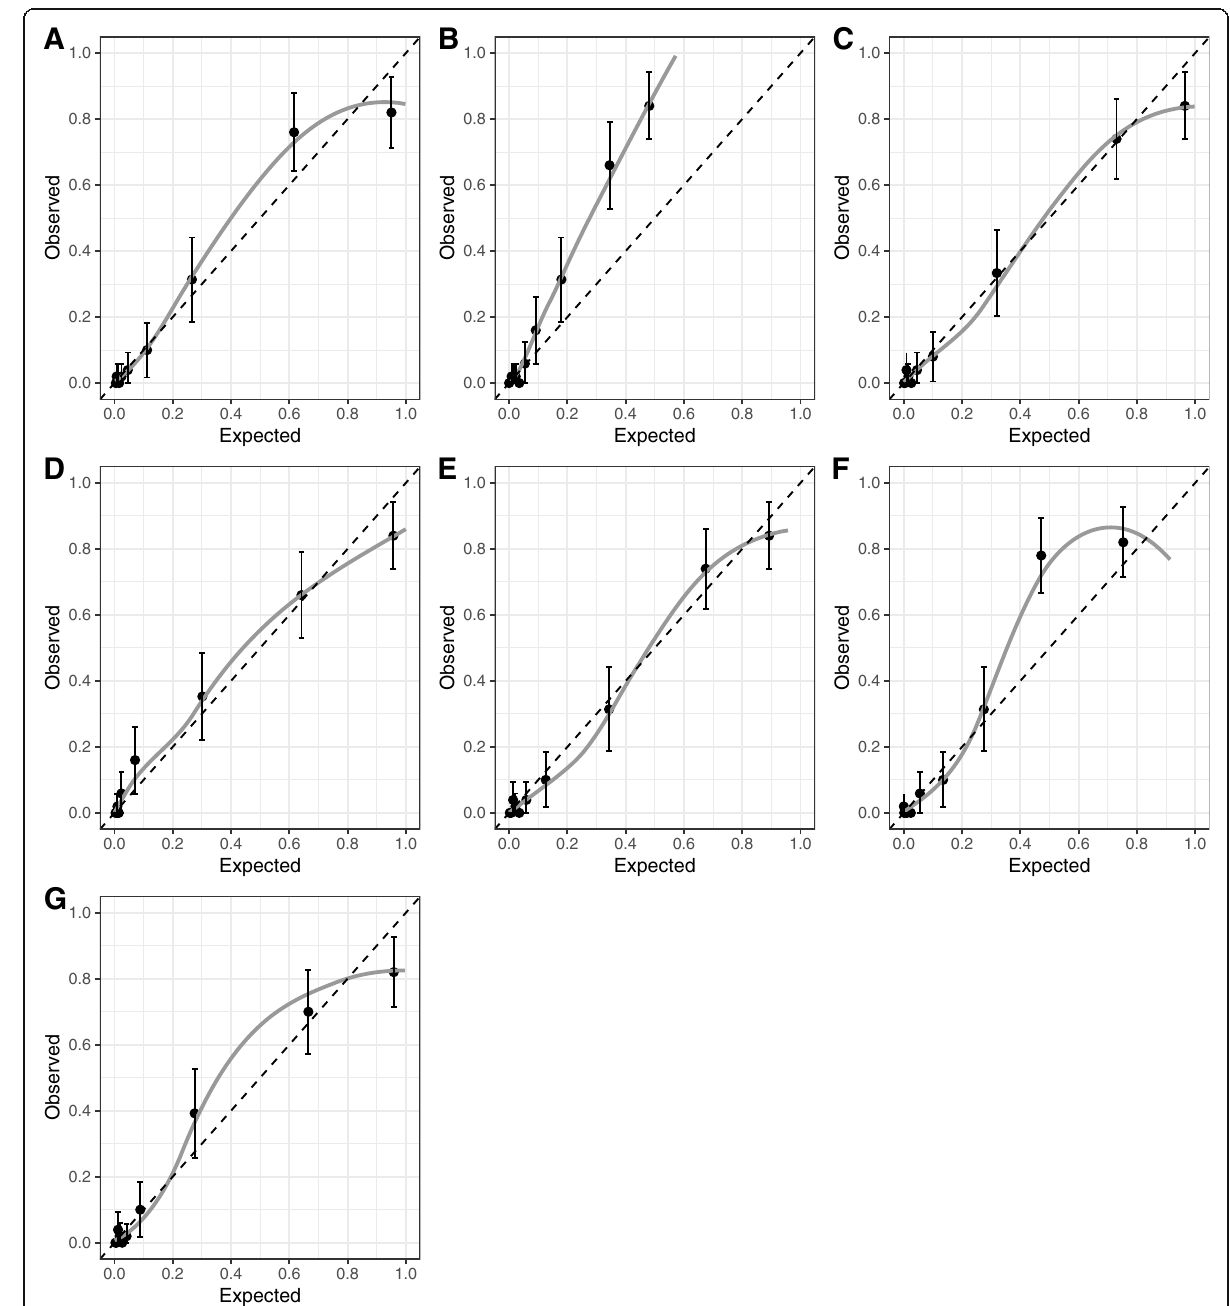
Fig. 1 Calibration plots with 95% confidence interval obtained using external validation dataset for prediction models. a Gradient boosting machine. b K-nearest neighbours. c Logistic regression. d MARS. e Neural network. f Random forest. g Support vector machine. Legend: Dashed line = reference line, solid black line = linear